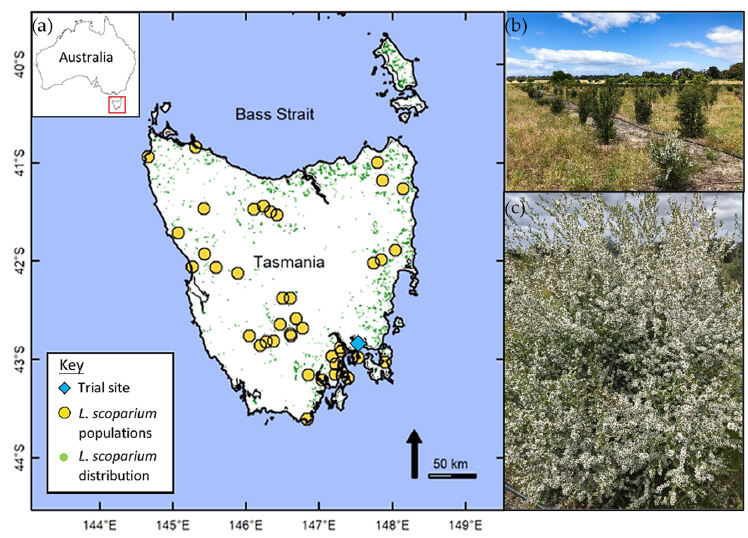
Figure 1. ( a ) Map of Tasmania showing trial site and population locations where open pollinated seed capsules of Leptospermum scoparium were collected. Green dots indicate recorded occurrences of L. scoparium obtained from Atlas of Living Australia [31], providing an indication of the species’ Tasmanian distribution. ( b ) Photograph of trial site plantation. ( c ) Photograph of L. scoparium in full